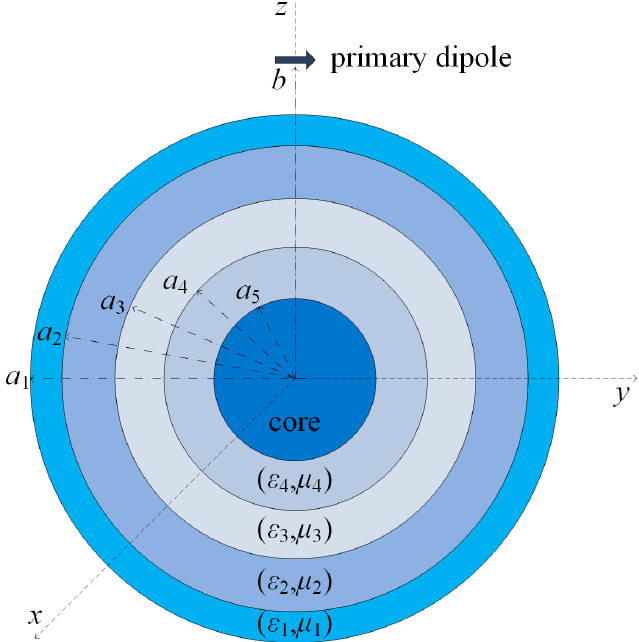
Figure 1. The considered scattering geometry of a layered spherical medium composed of a PEC or dielectric core of radius a 5 covered by four spherical shells with radii a j , permittivities (cid:101) j , and permeabilities µ j ( j = 1,2,3,4). The medium is excited by a magnetic dipole located at ( 0,0, b )